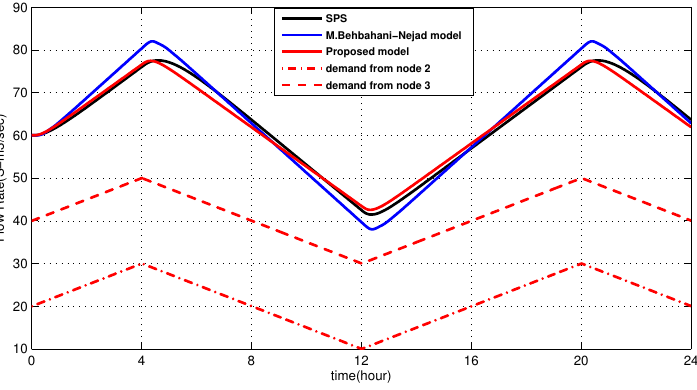
Figure 10. Demands for node 2 and node 3 and inlet flow rate for node